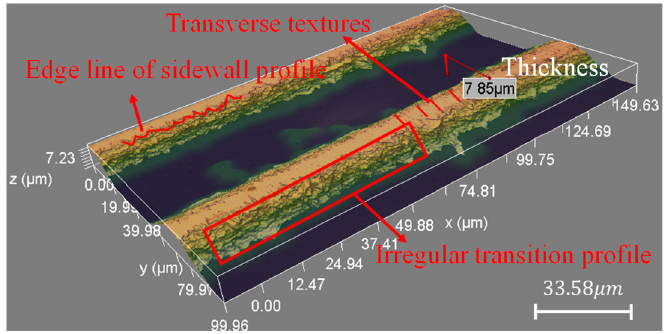
Figure 2. 3D model of a single grid measured by a Zego interferometer.